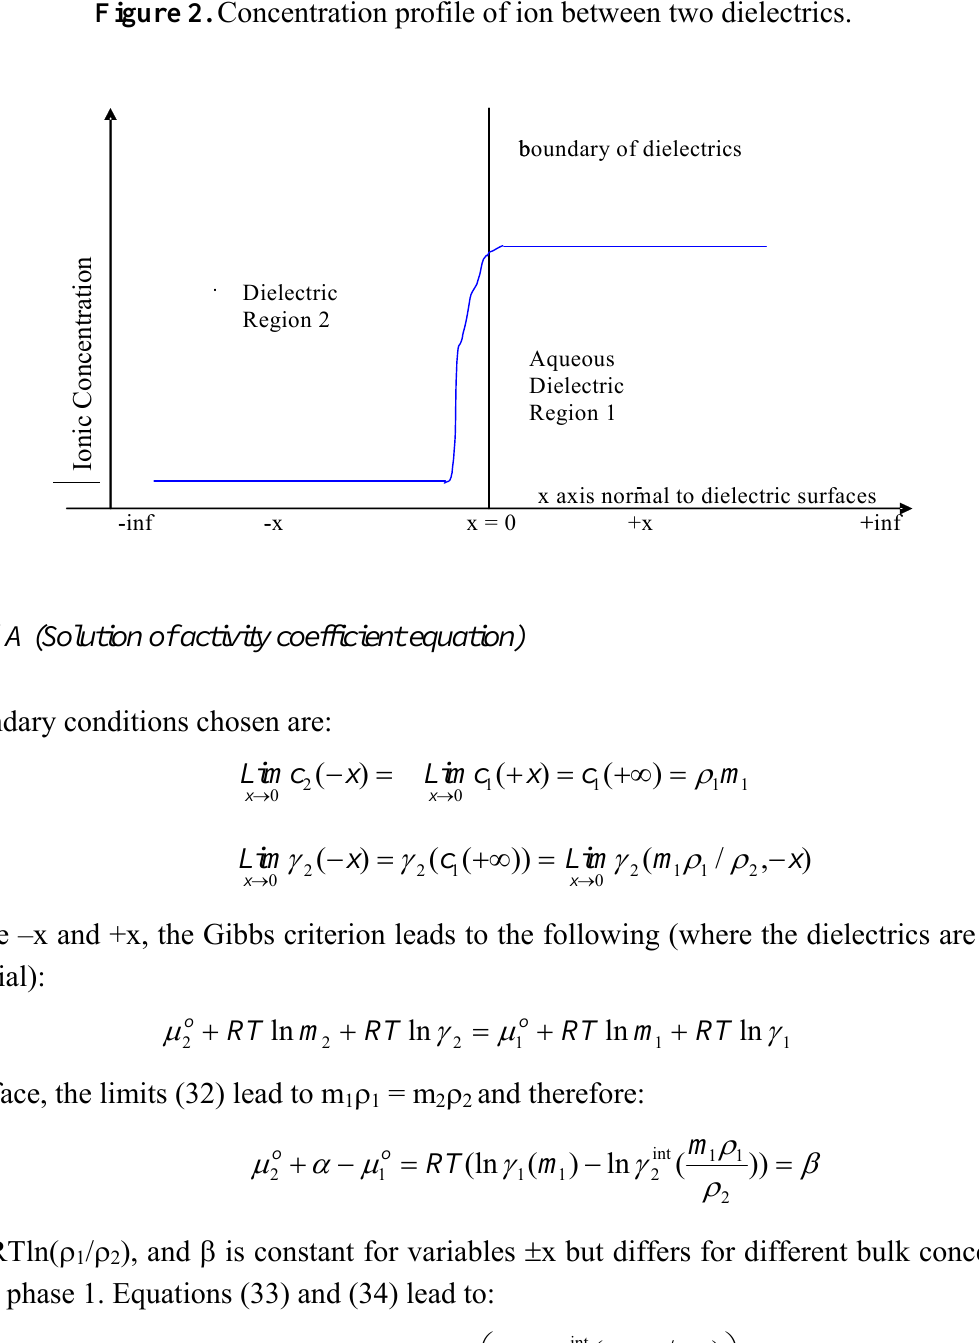
Figure 2. Concentration profile of ion between two